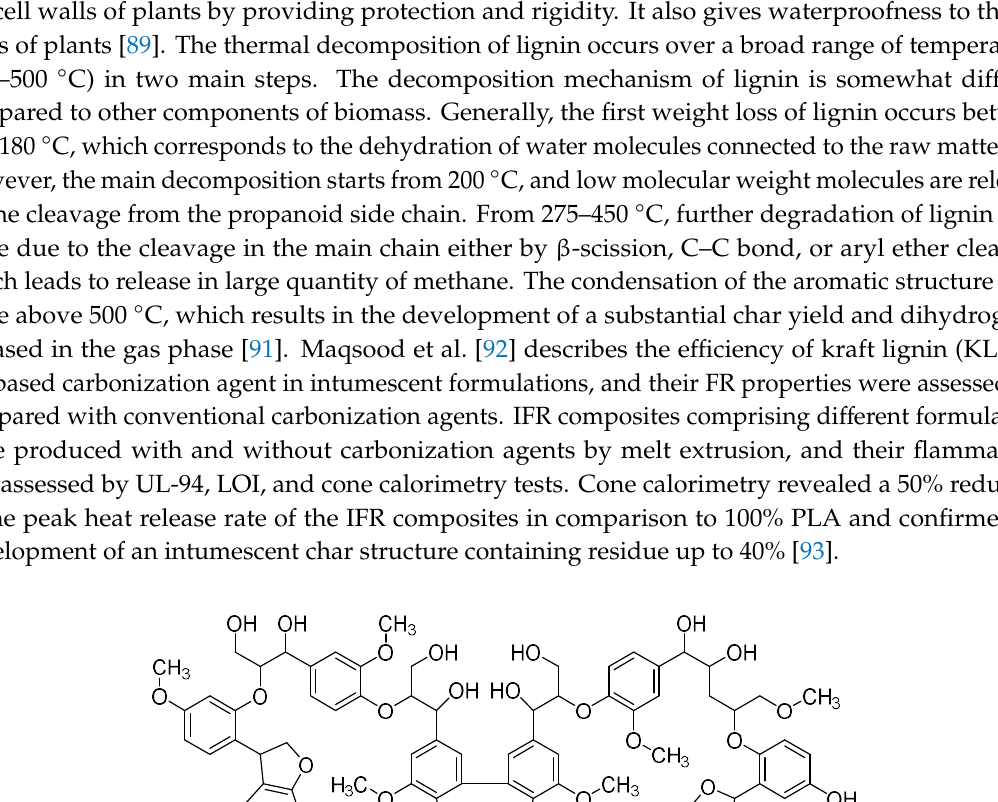
Table 2. Approaches used to make polylactic acid (PLA) flame-retardant.